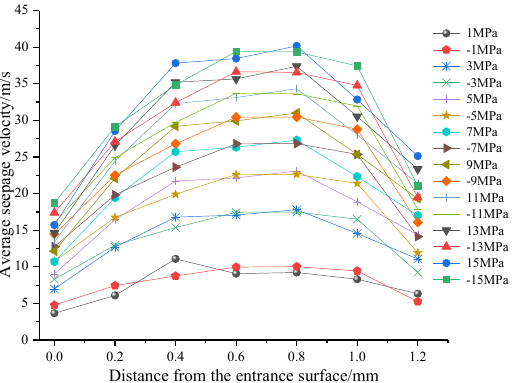
Figure 23. The seepage velocity curve of each section under different pressure drops.